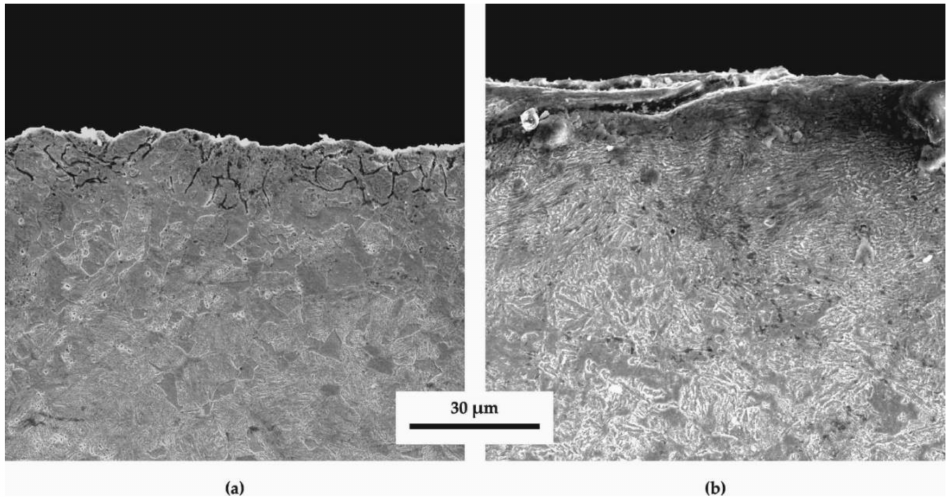
Figure 5. SEM images of longitudinal sections close to the surface of the ( a ) HTT and ( b ) HTT + SSP specimens.